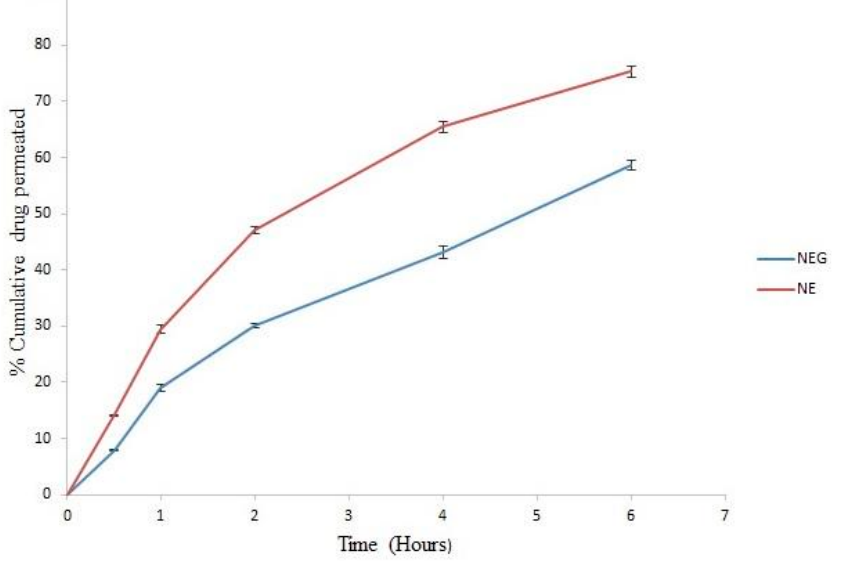
Figure 6. Permeation profile of minocycline nanoemulsion (NE) and minocycline nanoemulgel (NEG).